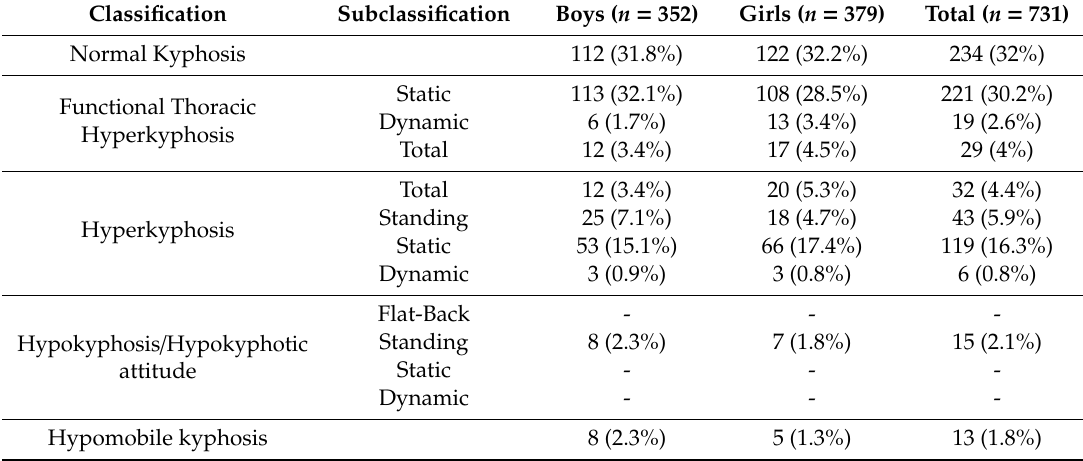
Table 5. Absolute and relative frequency of children in each classification and subclassification of “Sagittal Integral Morphotype” for the thoracic curve.